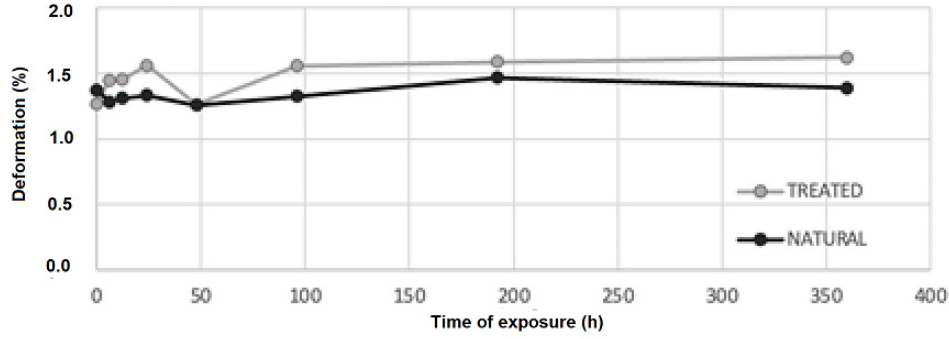
Figure 7. Change in deformation of the external part of the wall fiber according to different times of exposure for the average values of natural and treated samples . Table 1. Average values and standard deviation (in brackets) for bending strength and deformation of the external part of bamboo thickness, referring to treated and natural samples exposed to differ- ent UV radiation hours.